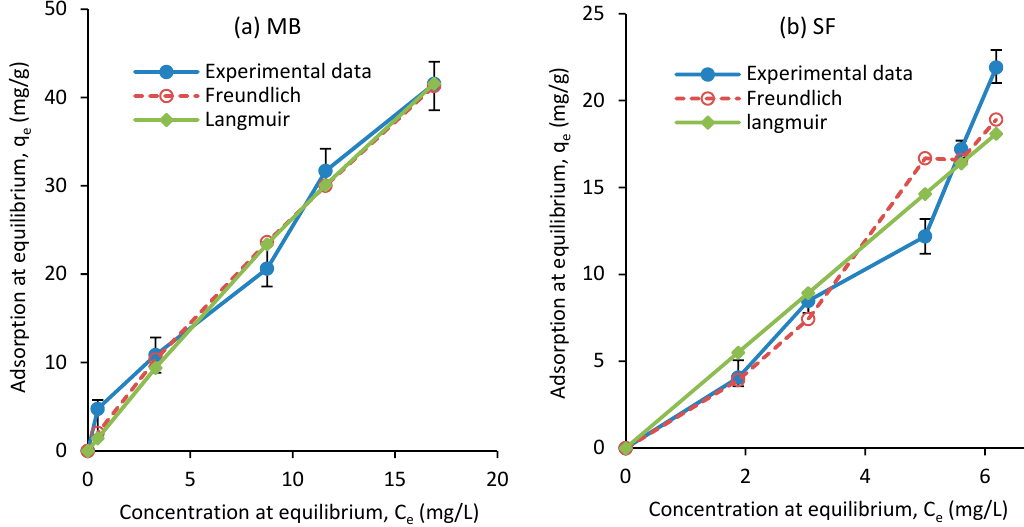
Figure 11. Isotherm adsorption of ( a ) MB and ( b ) SF on the adsorbent obtained experimentally and from the Langmuir and Freundlich models.